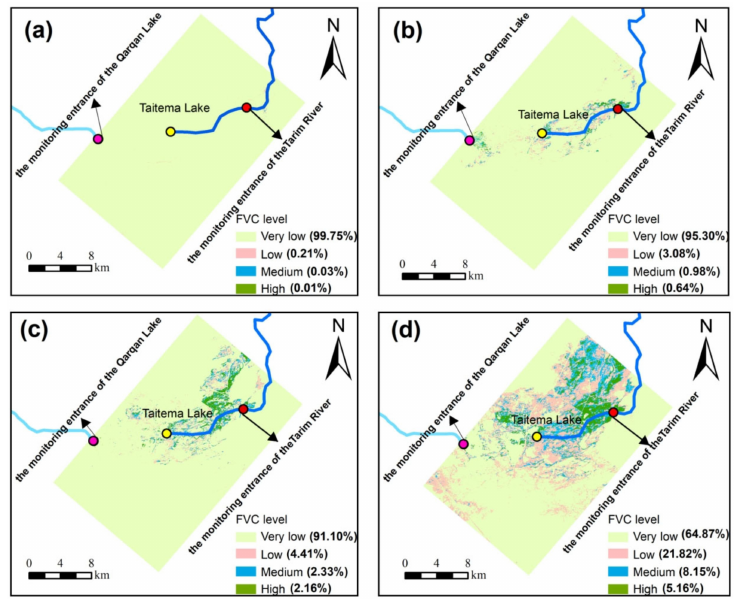
Figure 3. Spatial distributions of the fractional vegetation cover of the Taitema lake region in 2001 ( a ), 2007 ( b ), 2014 ( c ), and 2018 ( d ).